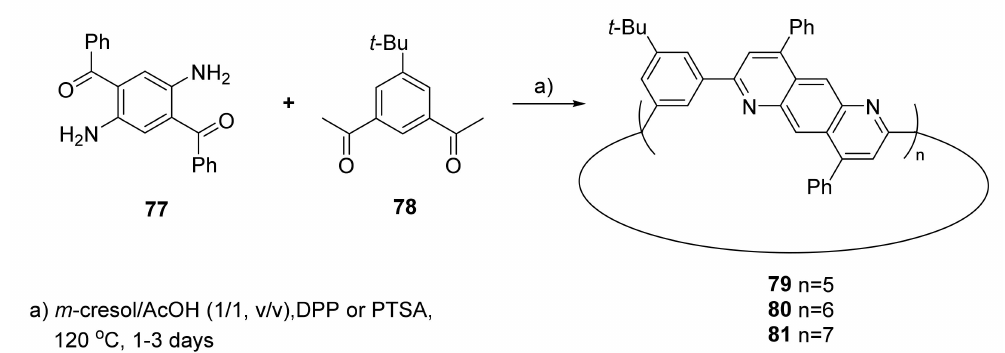
Figure 15. Synthetic route to 1,6-anthrazoline-containing, π -conjugated polyaza macrocycles 79 – 81